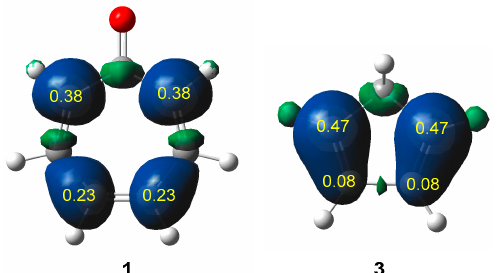
Figure 2. Three-dimensional representations of the Mulliken atomic spin densities of the radical anion of tropone 1 and the radical cation of Cp 3 , including the electrophilic 𝑃 (cid:3038)(cid:2878) Parr functions of tropone 1 and the nucleophilic 𝑃 (cid:3038)(cid:2879) Parr functions of Cp 3 .